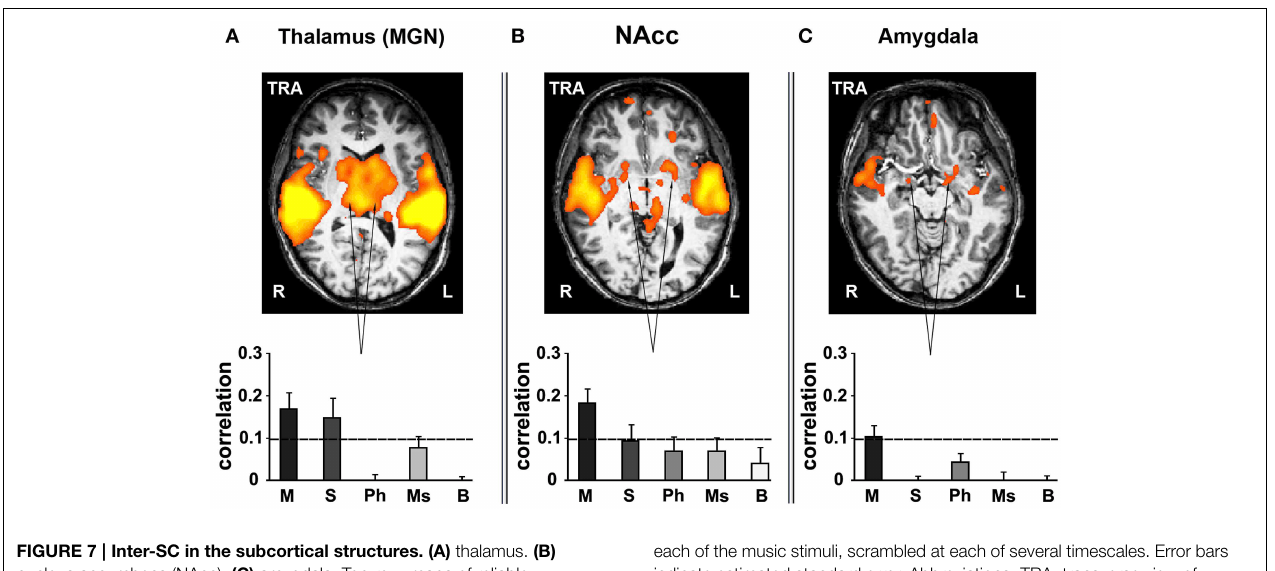
FIGURE 7 | Inter-SC in the subcortical structures. (A) thalamus. (B) nucleus accumbens (NAcc). (C) amygdala. Top row, maps of reliable responses to the intact music stimulus. Bottom row, inter-SC is plotted for